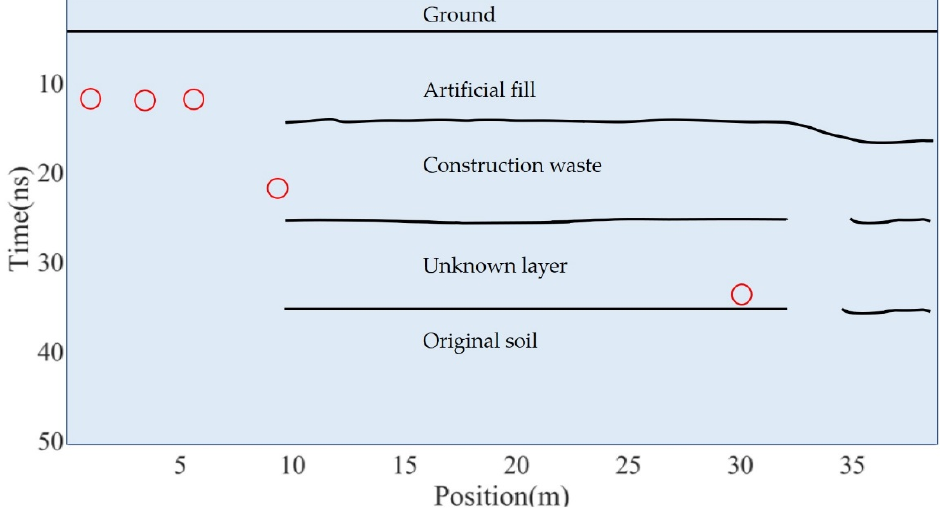
Figure 8. Interpretation for Figure 4c. Four layers are described and the locations of five pipelines are marked by red circles.